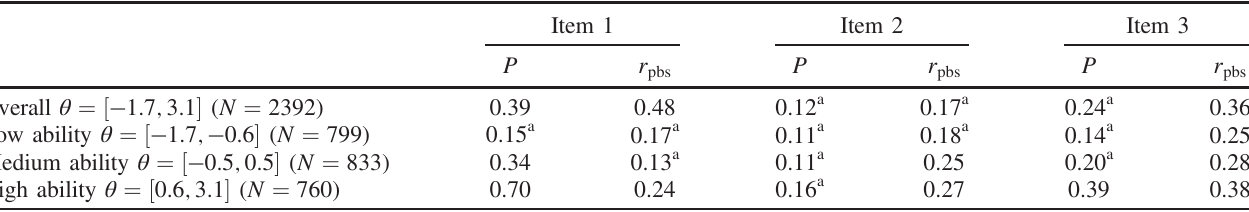
TABLE I. Item difficulty index ( P ) and point-biserial coefficient ( r and for three ability levels of Thai